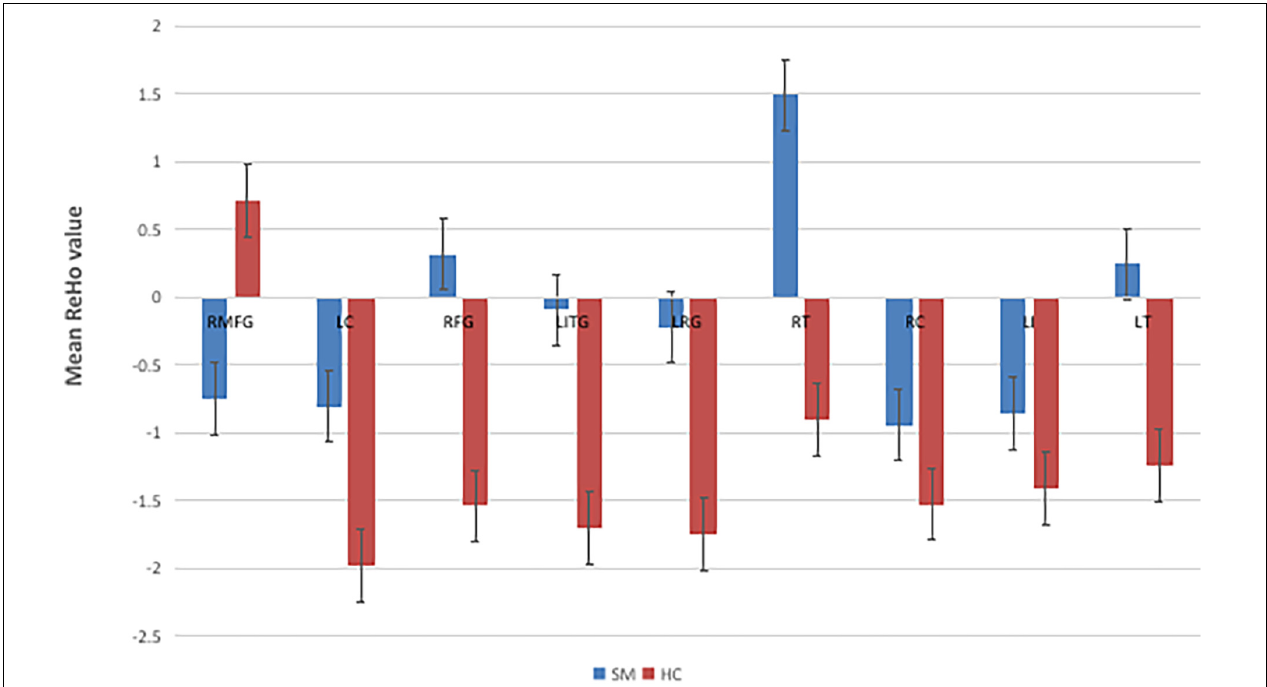
FIGURE 3 | The mean single ReHo value between the SMs group and HCs. RMFG, right middle frontal gyrus; LC, left cerebellum; RFG, right fusiform gyrus; LITG, left inferior temporal gyrus; LRC, left rectus gyrus; RT, right thalamus; RC, right caudate; LI, left insula; LT, left thalamus; ReHo, regional homogeneity; HCs, healthy controls; SM, severe obesity and meibomian gland